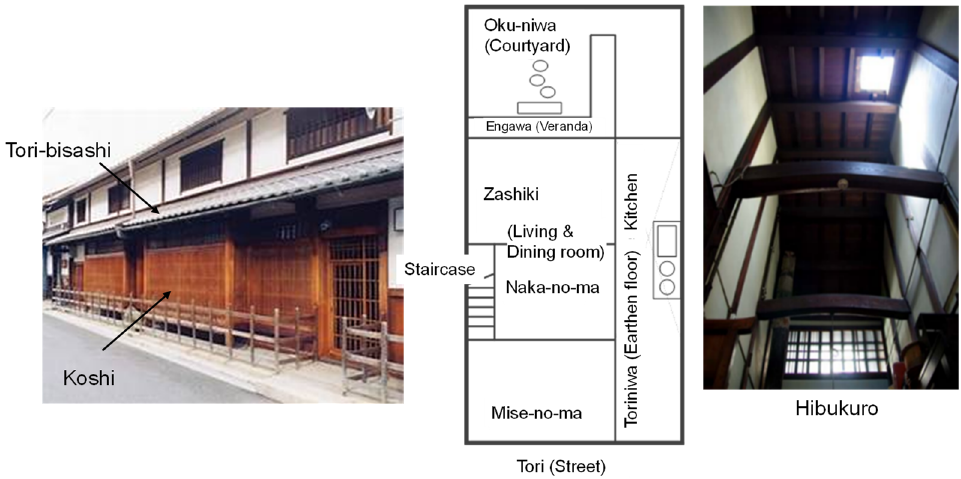
Figure 2. Typical appearance and floor plan of a Kyo-machiya (townhouse-type).